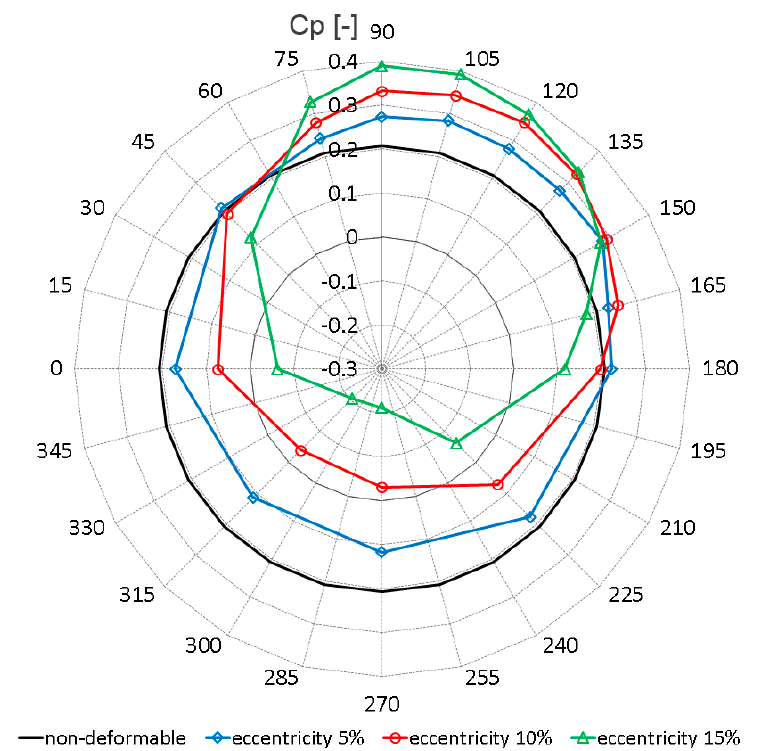
Figure 7. Polar plot of the power coefficient Cp for deformable blade rotors with different magnitudes and positions of eccentricity.